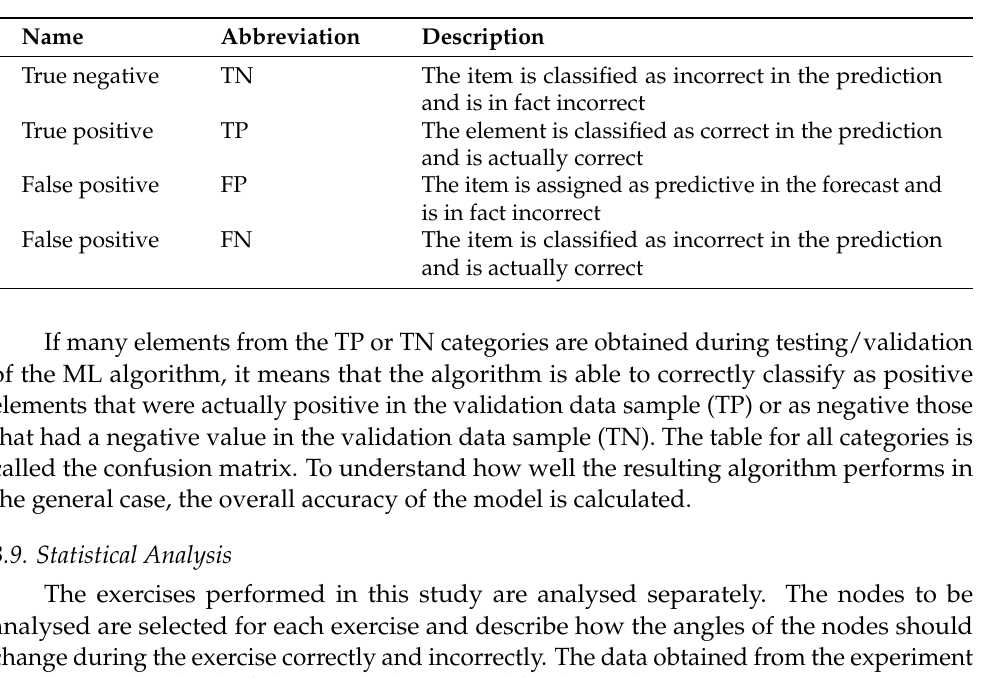
Table 1. Categories of classification items obtained from the